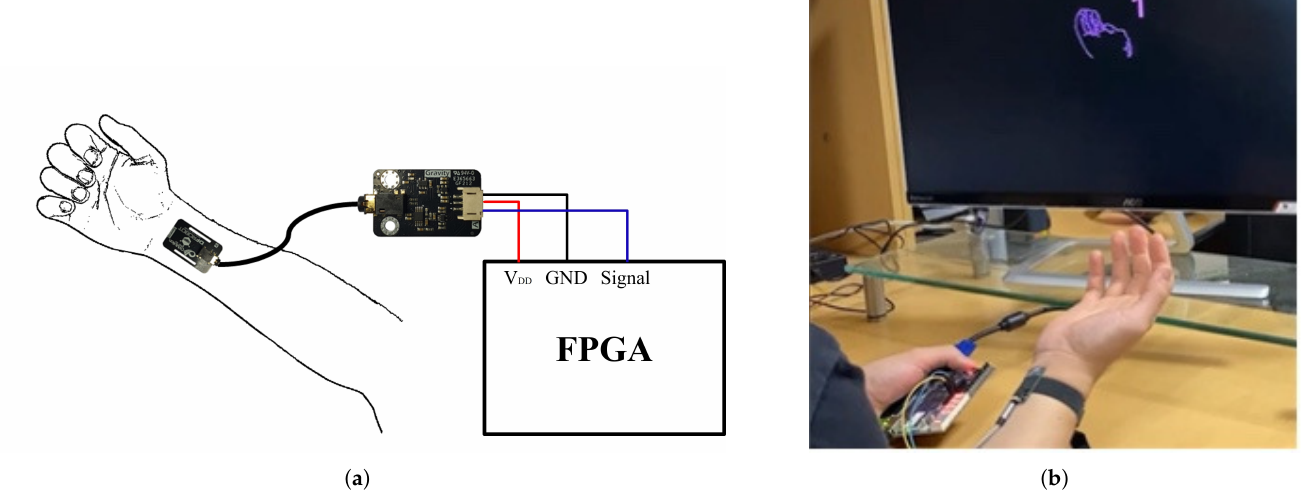
Figure 10. Experimental environment: ( a ) example of sensor being worn; ( b ) experimental environ- ment with